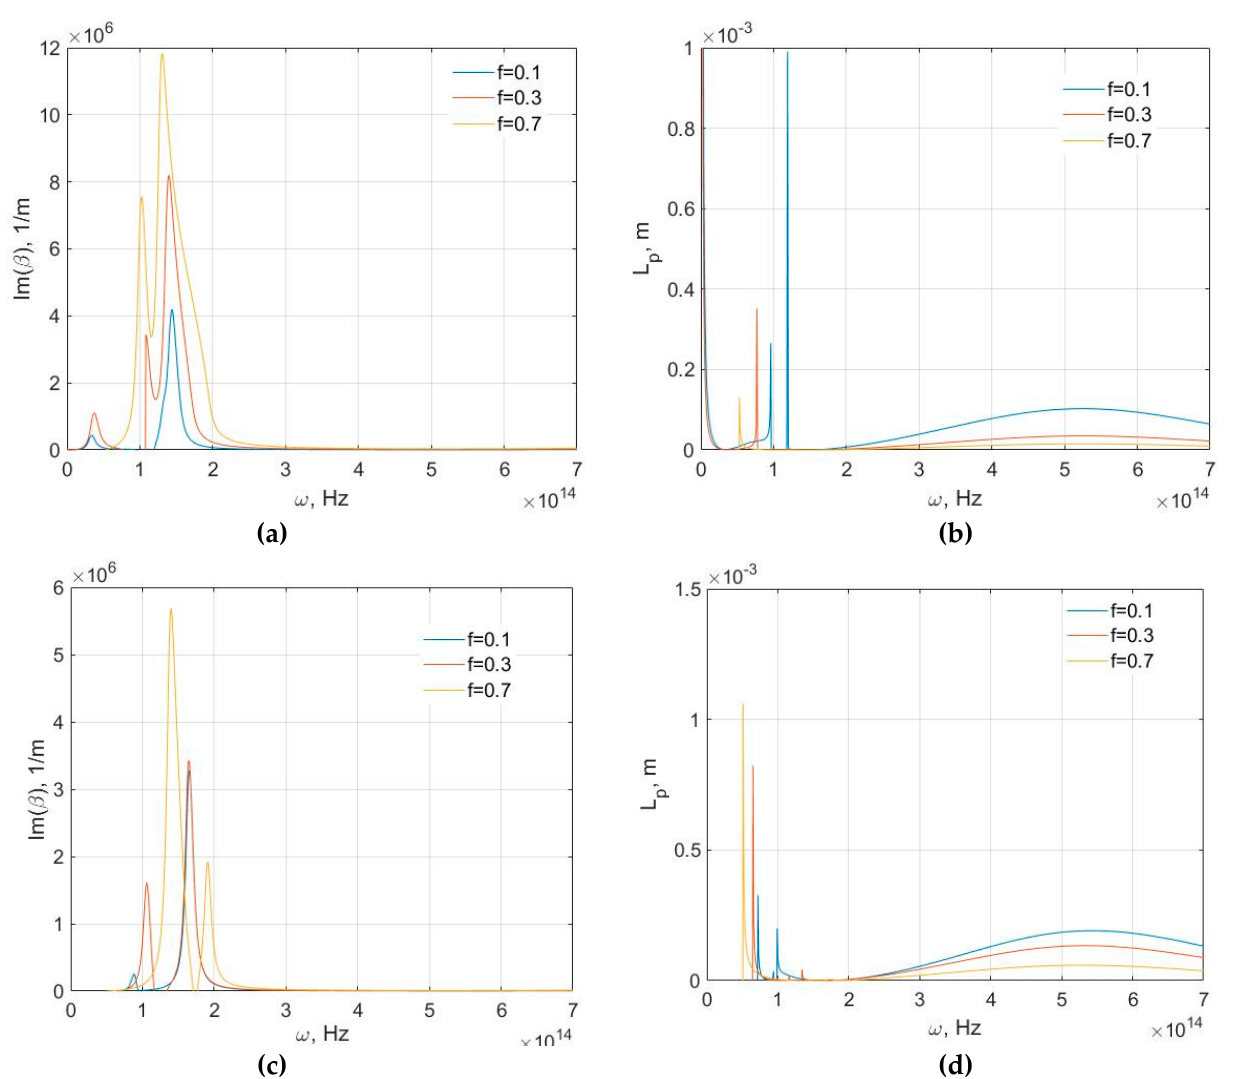
Figure 4. Dependence of transmission characteristics versus frequency for different filling factors: ( a , c ) the imaginary part of β ; ( b , d ) the propagation length L p . The case ε n = 2.25, ε d = 11.8.is presented in ( a , b ); ε n = 11.8, ε d = 2.25—( c , d ). All of the presented results were obtained for the AZO